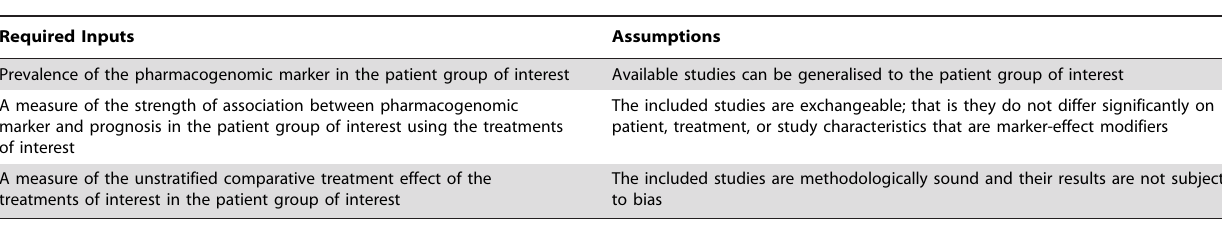
Table 1. Required inputs and assumptions of the indirect estimation